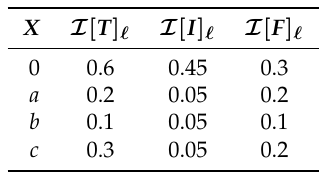
Table 3. Interval neutrosophic length of I